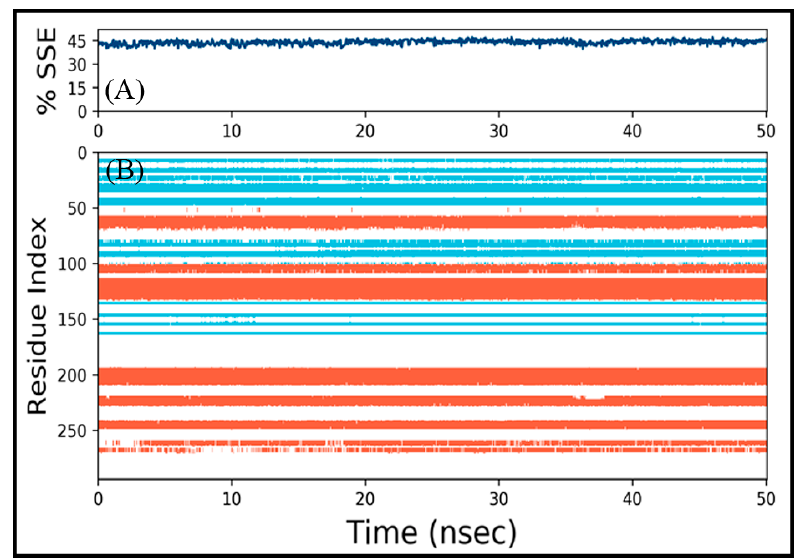
Figure 7. ( A ) Variation in secondary structure element (SSE) of PLK-1 during simulation, ( B ) partici- pation of individual amino acid residues in contributing towards the formation of α -helices (light brown color bars) and β -sheets (teal color